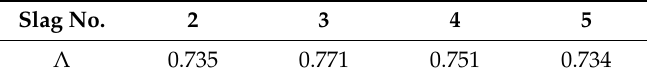
Table 7. Average optical basicity of the smelting separation slag. Slag